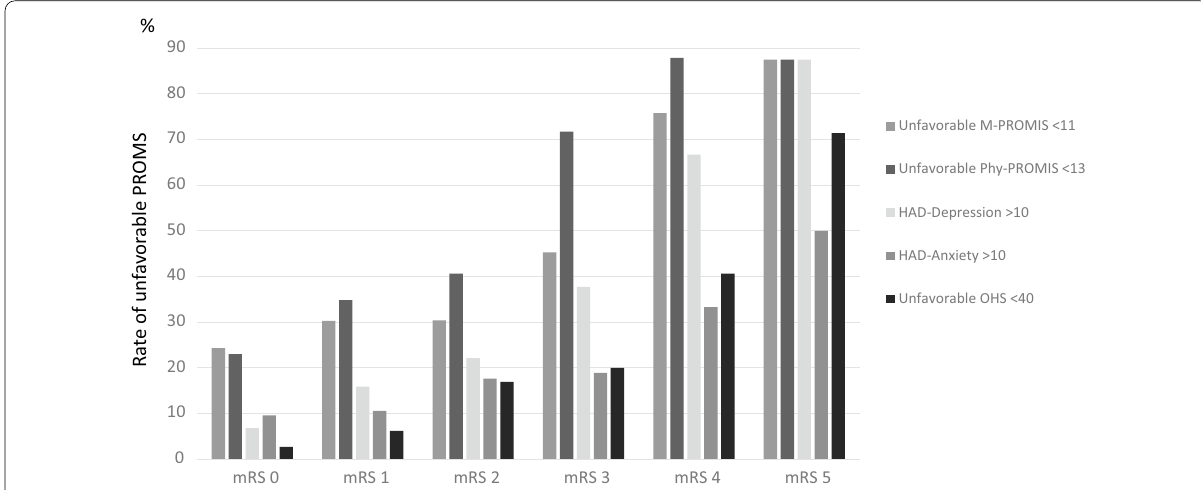
Fig. 7 Rate of unfavorable results in the different PROMs evaluated at 3 months after stroke related to the 3 months mRS